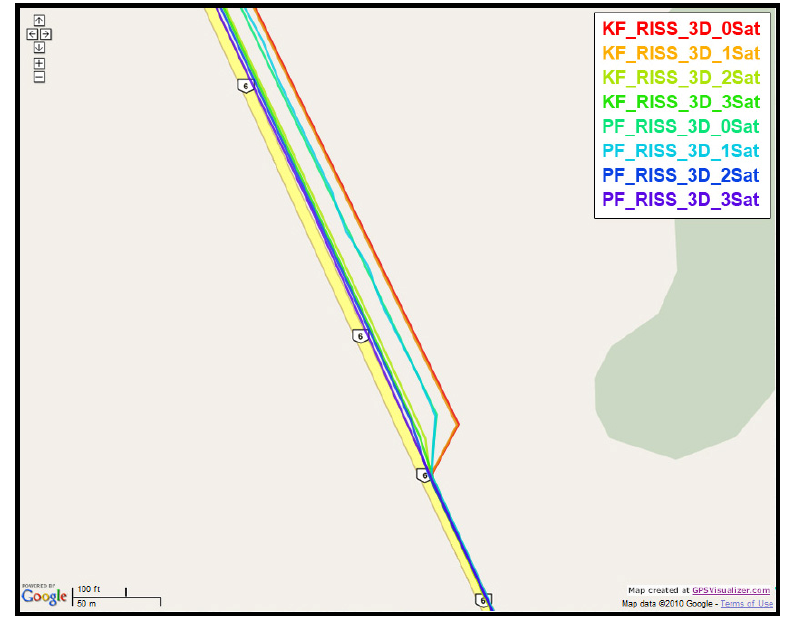
Figure 9. Performance towards the end of the simulated GPS outage #7 of the first trajectory.